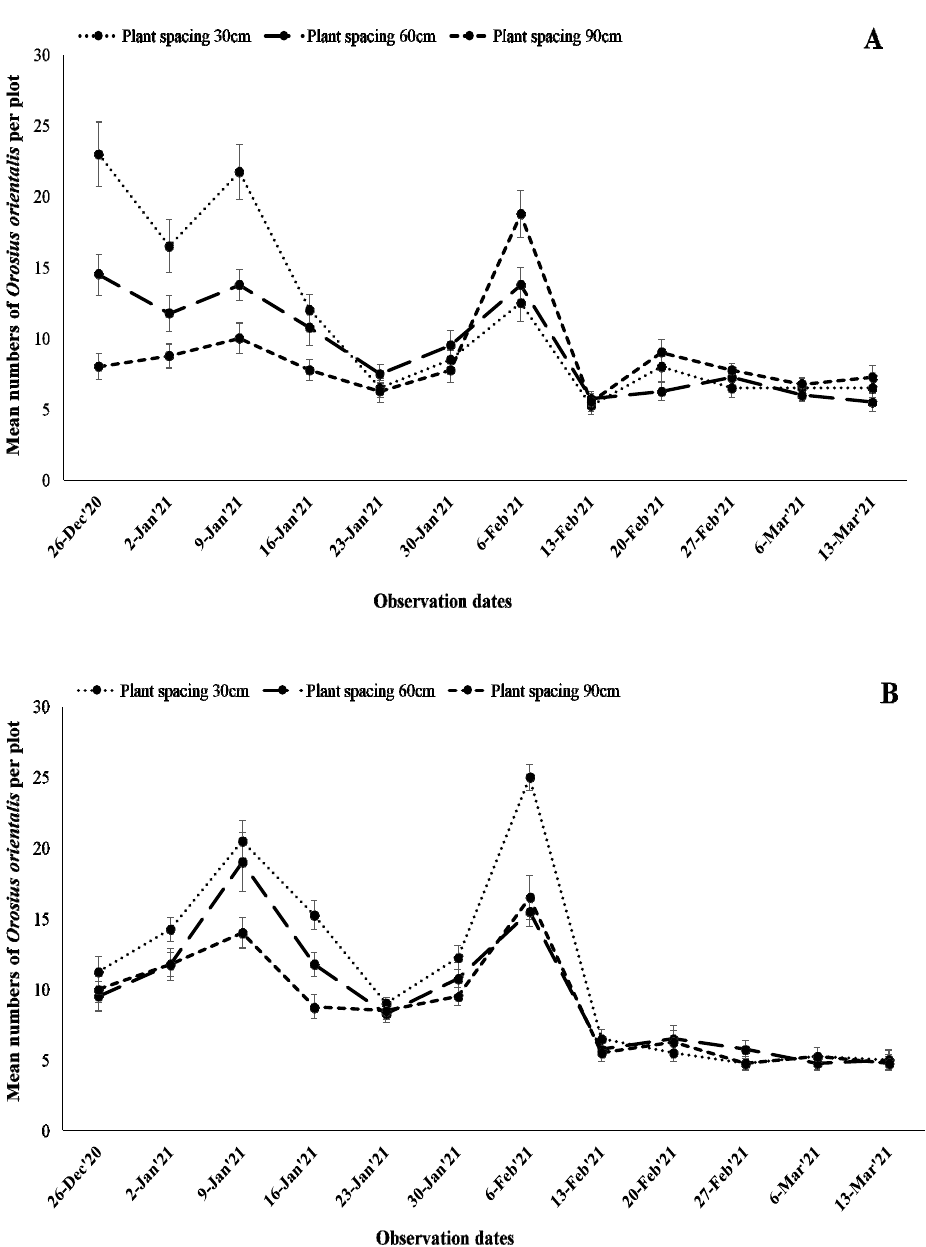
Figure 1. Temporal distribution of Orosius orientalis within three plant spacings (30 × 50 cm, 60 × 50 cm and 90 × 50 cm) of two tomato varieties [Areenez F1 ( A ) and Tala F1 ( B )] (the mean of Orosius orientalis /week ± SE).